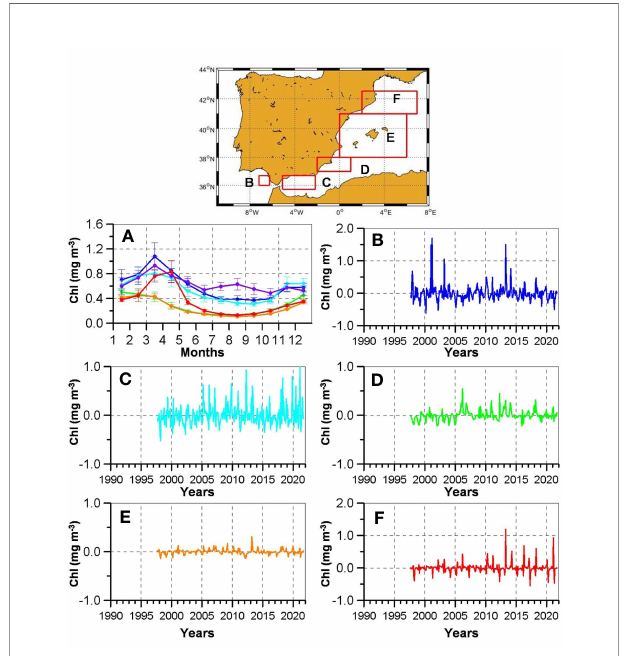
FIGURE 9 | Seasonal chlorophyll concentration (A) and the corresponding time series of anomalies computed for the fi ve study regions: Gulf of Ca ́ diz (blue line, B ), Albora ́ n Sea (blue light line, C ), Cape Palos (green line, D